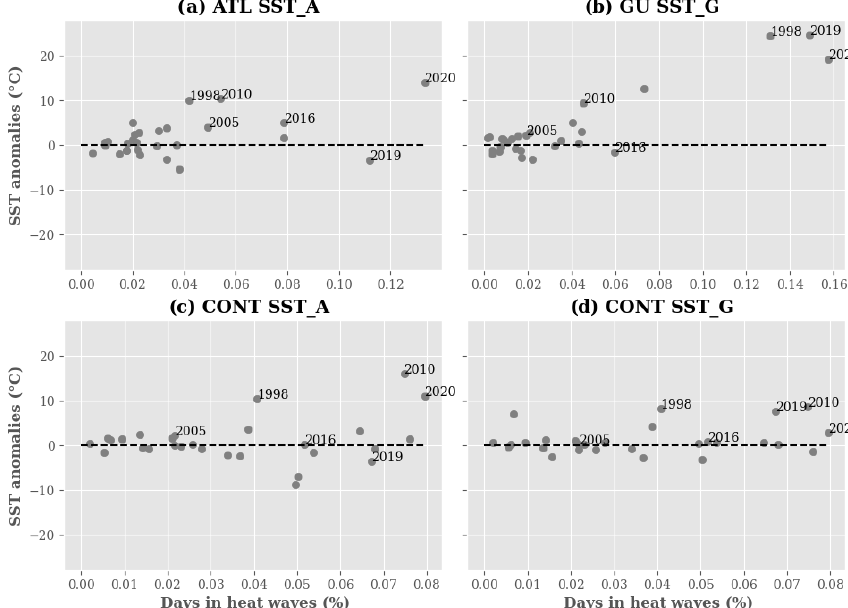
Figure 11. Analysis of the link between SST anomalies and heat waves days over the period 1993–2020 using ERA5 reanalysis and maximum values of T 2m in the different regions: (a) ATL, (b) GU, (c–d) CONT. SST_A and SST_G represent the boxes using to compute the SST mean anomalies for the ATL and CONT regions respectively (see Fig. 1). The anomalies are computed as the difference between monthly SST and the monthly climatological values of the SST over the whole period. For each year, the yearly anomalies of SST are computed with respect to the heat waves days. The x and y axes represent the frequency of heat waves days and the SST anomalies respectively. The grey dots represent the years over the period